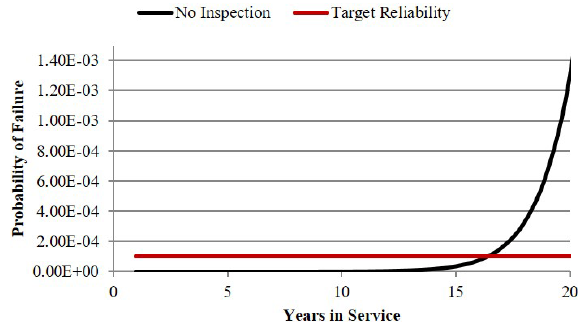
Figure 14. Example of a time-dependent fatigue and fracture relia- bility